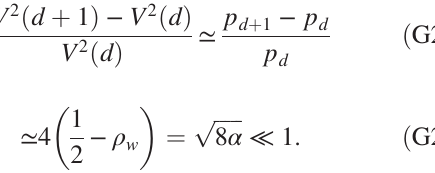
FIG. 17. The solid line shows the dependence of l ð w Þ on α ¼ ð 1 =n Þ log 2 w from Eq. (G15). The dashed line shows the tangent to the solid curve at the point α ¼ 0 ( w ¼ 1 ). This line corresponds ffiffiffiffiffiffiffiffiffiffiffi p to l ð w Þ ≃ log w , in accordance with Eq. (G24). The inset shows the dependence of the root ρ of Eq. (G12) on α ¼ log 2 w 1 =n . w ≈ 1 = 2 . Near Small α ≪ 1 corresponds to Hamming distances ρ w that point, the dependence of ρ on α follows Eq. w